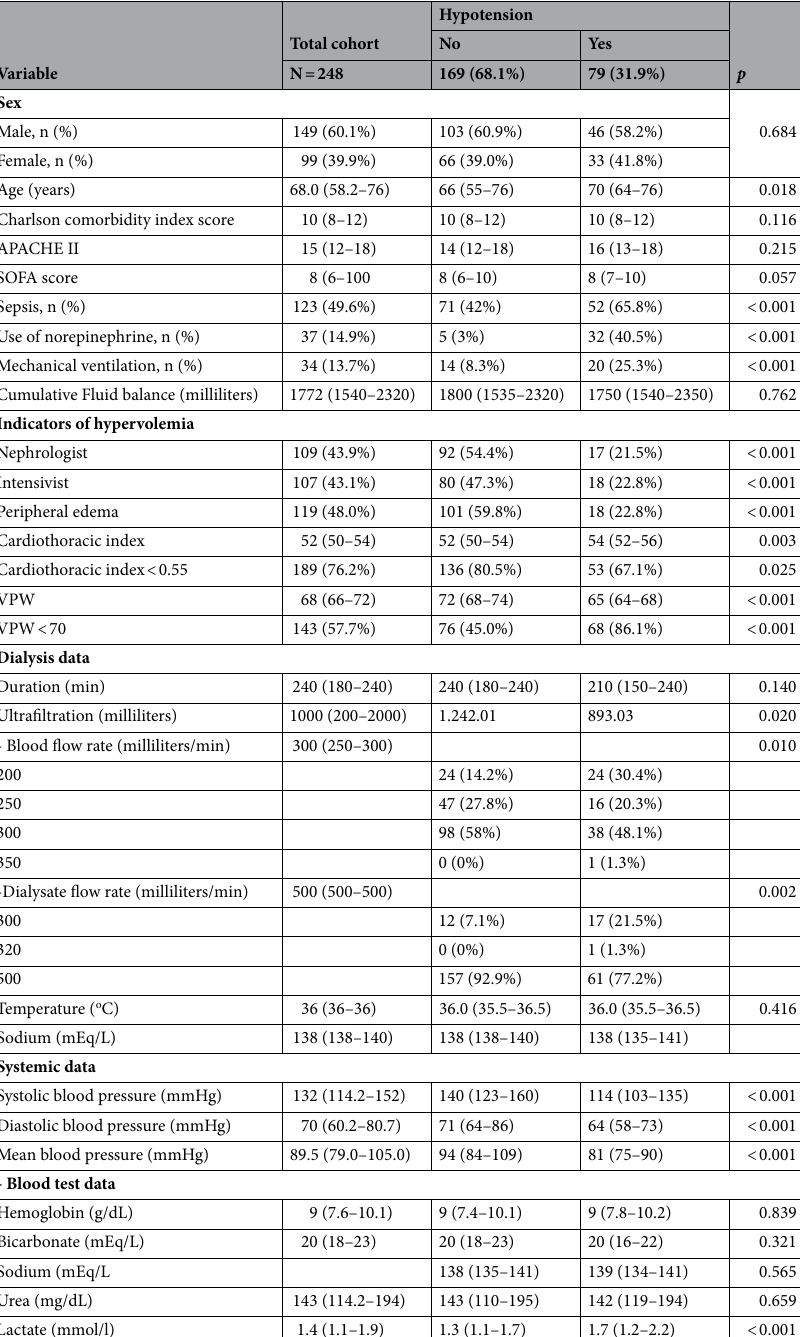
Table 1. Distribution of parameters according to the occurrence of hypotension (univariate analysis). SOFA sequential organ failure assessment, APACHE acute physiology and chronic health evaluation, CTR cardiothoracic